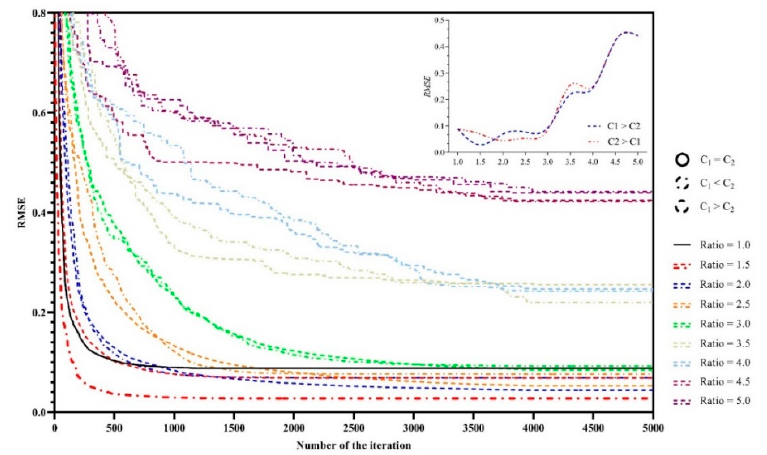
Figure 13. ANFIS-PSO: evolution of the RMSE during the optimization by PSO, as a function of the values of the cognitive and social acceleration coefficients C 1 and C 2 .